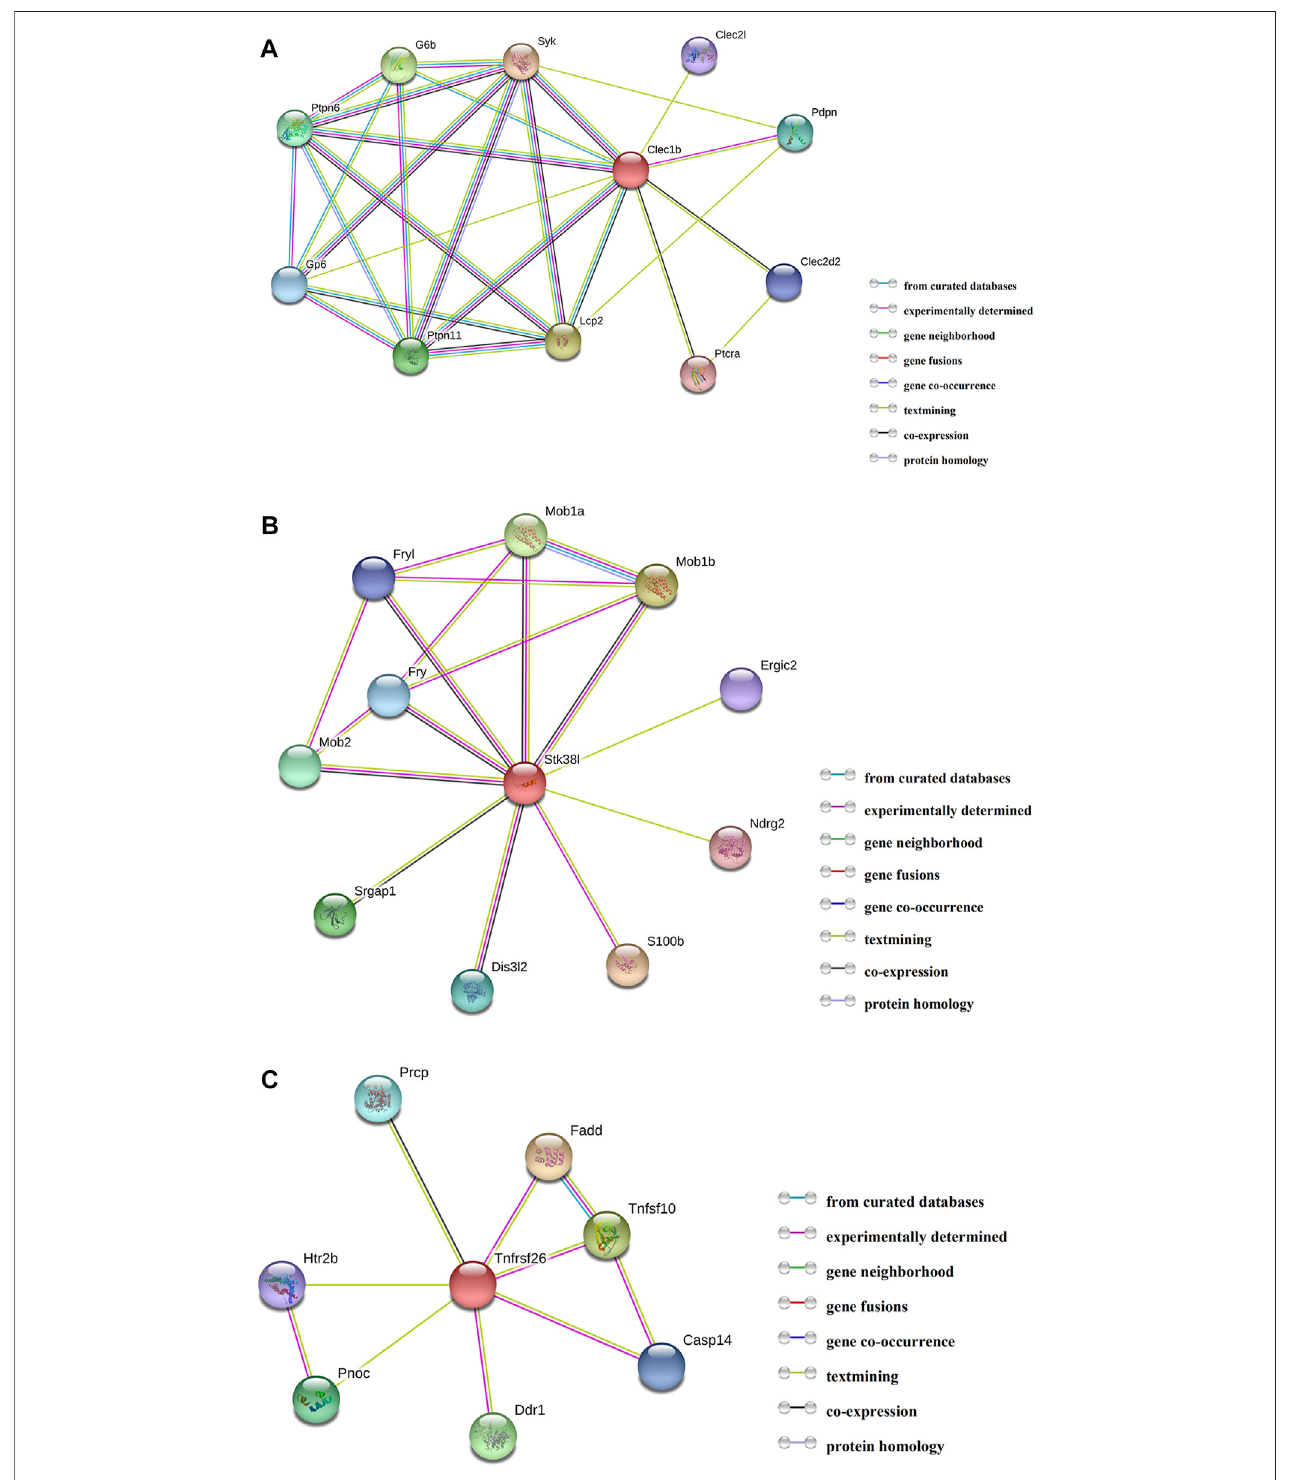
FIGURE5| Protein – proteininteractionanalysis. (A) PPInetworkofClec1b, (B) PPInetworkofStk38l, (C) PPInetworkofTnfrsf26.PPI,protein – proteininteraction; Clec1b, C-type lectin domain family 1 member B; Tnfrsf26, tumor necrosis factor receptor superfamily member 26; STK38L, serine/threonine kinase 38 like.